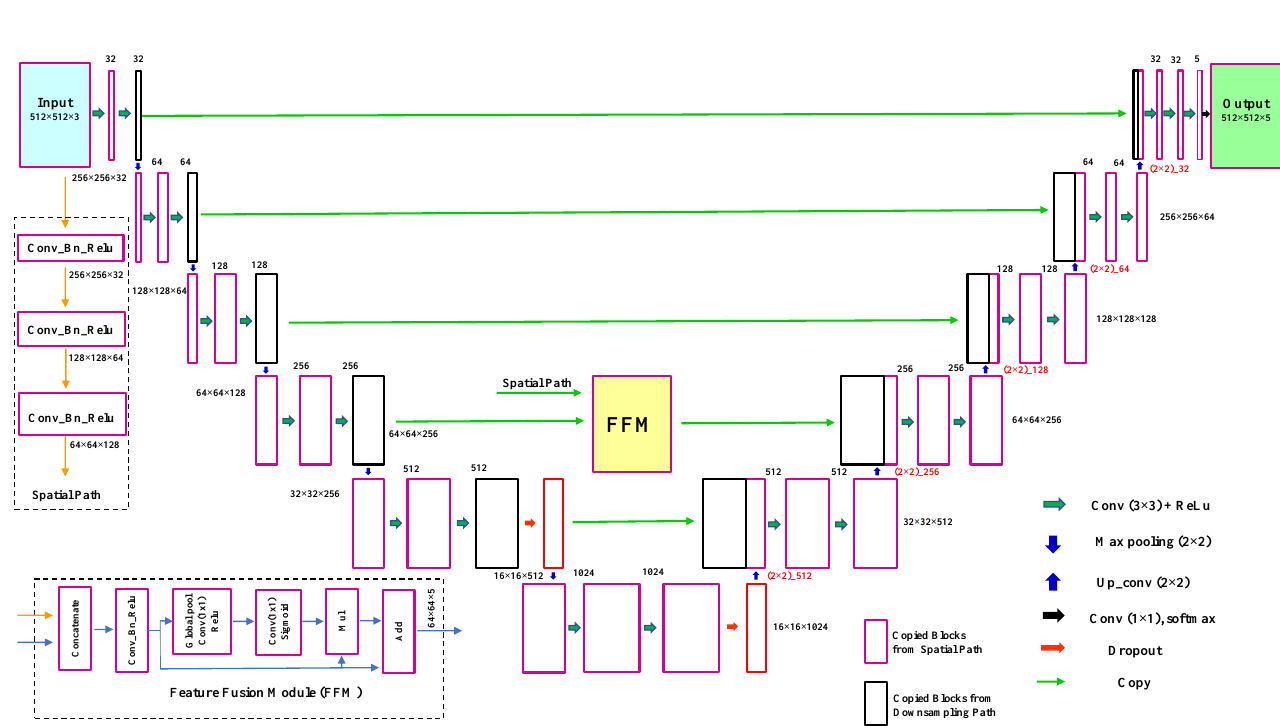
Figure 3. LumbarNet uses an end-to-end architecture for object semantic segmentation. It takes a three-channel input image at a resolution of 512 × 512 and produces an output containing five